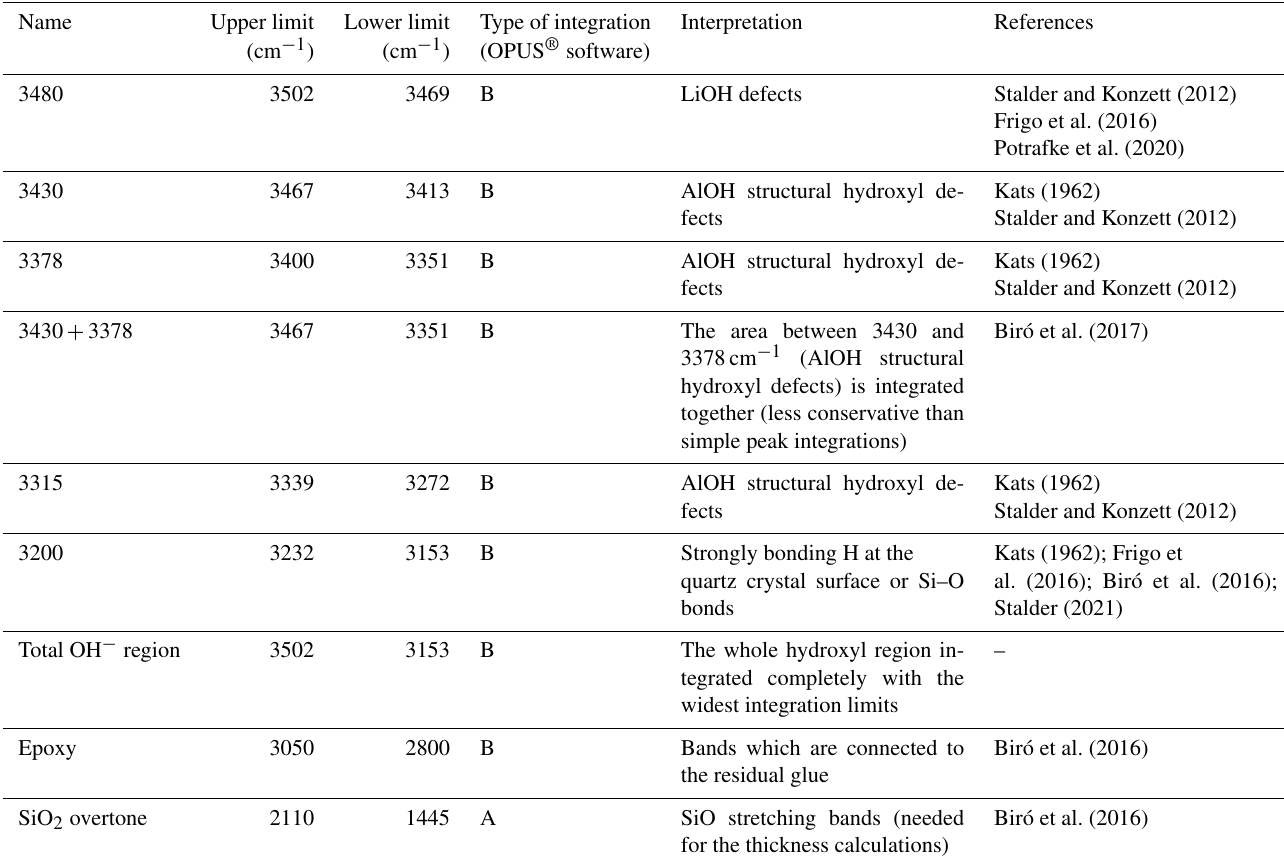
Table 2. Integration boundaries and their interpretation. Bands in bold are used for the calculation of structural hydroxyl content of quartz phenocrysts in this work.